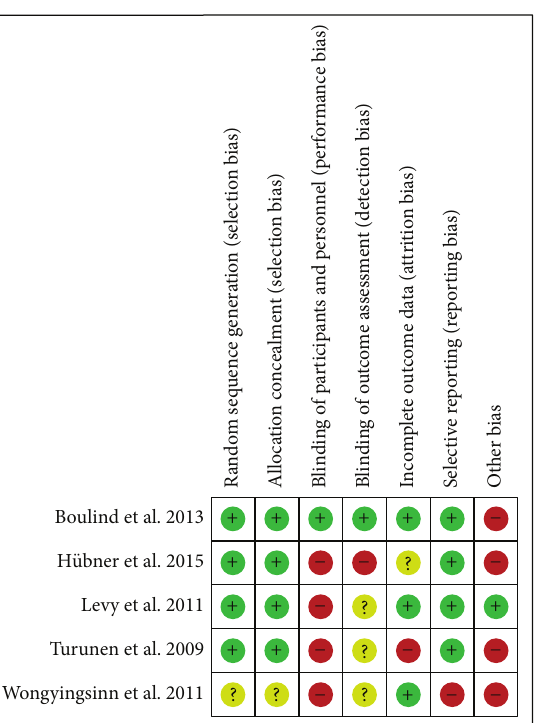
Figure 2: Risk of bias